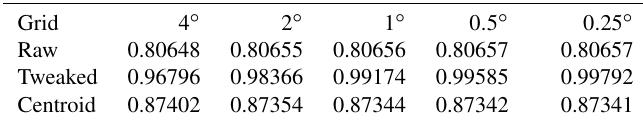
Table 1. Properties of the raw, tweaked, and centroid grids; numerical columns are for grid levels 4 through 8. ArcA is the arc between adjacent primary cell corners or momentum cell centers. ArcC is the arc between nearby primary cell centers or momentum cell corners. Point D is intersection of ArcA and ArcC. The ideal number is 1 for first three properties and 0 for last two properties. Radius is the square root of cell area divided by π